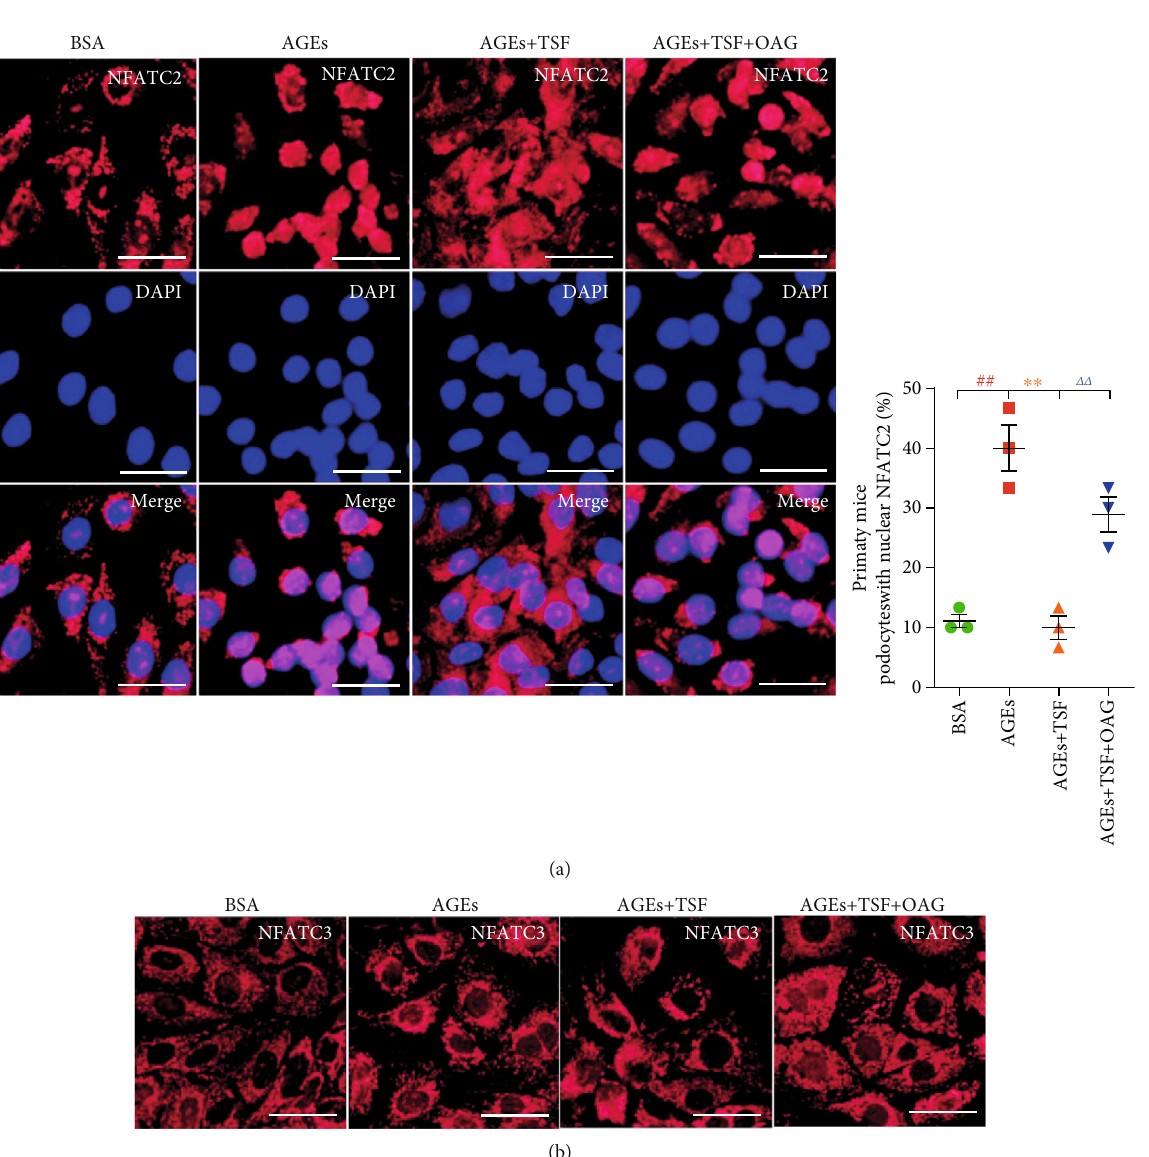
Figure 8: TSF alleviated NFATC2 nuclear translocation in AGEs-stimulated primary mice podocytes. (a) Representative immuno fl uorescence staining and quantitative analysis of NFATC2 (scale bars, 50 μ m; 30 cells evaluated per experiment, n = 3 experiments). Nuclei were stained with DAPI. (b) Immuno fl uorescence staining for NFATC3 (scale bars, 50 μ m). The data were expressed as the mean ± SEM . # P < 0 : 05 , ## P < 0 : 01 vs. BSA group; ∗ P < 0 : 05 , ∗∗ P < 0 : 01 vs. AGEs group; Δ P < 0 : 05 , ΔΔ P < 0 : 01 vs. AGEs + TSF group. Statistically analyzed via a one-way ANOVA with Dunnett ’ s